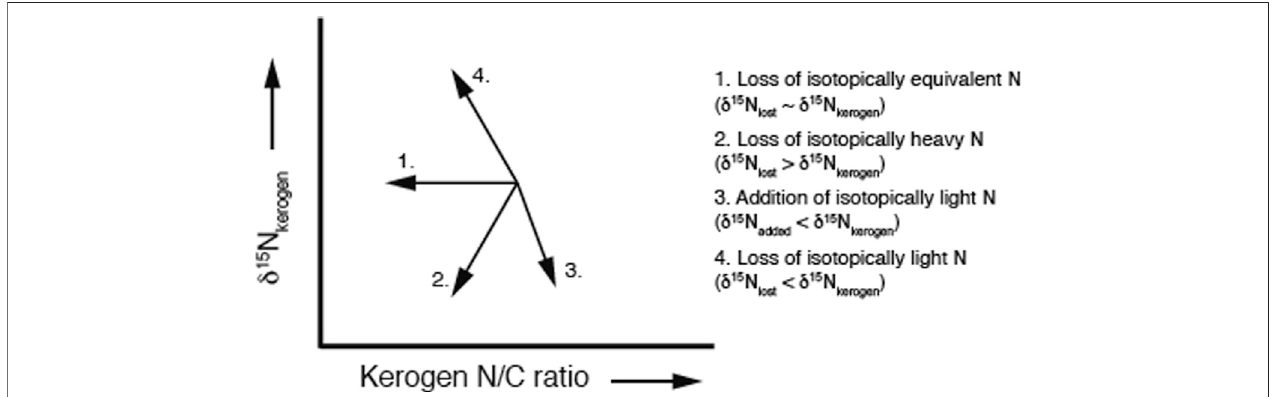
FIGURE 3 | The arrows illustrate the relationships between kerogen N/C ratio and the δ 15 N kerogen values for four possible diagenetic and catagenetic pathways. If nitrogenislostthathasasimilar δ 15 Nvalueastheoriginalkerogen,theN/Cratiowilldecreasewithoutchangingthe δ 15 N kerogen (arrow1).LossofisotopicallyheavyNwill resultindecreasingvaluesforboth N/Cratioand δ 15 N kerogen (arrow2).Ifdiagenetic/catagenic processes resultintheaddition ofNcompoundsthatareisotopicallylight, δ 15 N kerogen will decrease while the N/C ratio increases (arrow 3). Removal of N compounds that have low δ 15 N kerogen values and a decrease in N/C ratio.